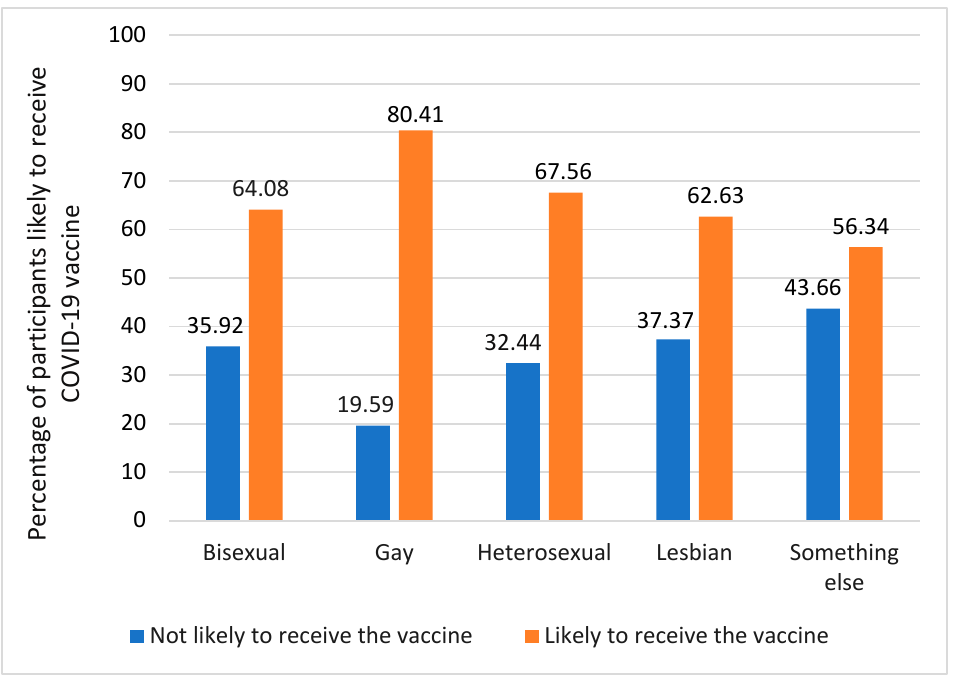
Figure 1. Prevalence of self-reported likelihood of receiving COVID-19 vaccine by sexual orientation. Table 1. Descriptive and bivariate analyses of likelihood of receiving COVID-19 vaccine by sociode- mographic characteristics, likelihood of contracting COVID-19, anxiety/depression, discrimination, and social distancing stress (N =